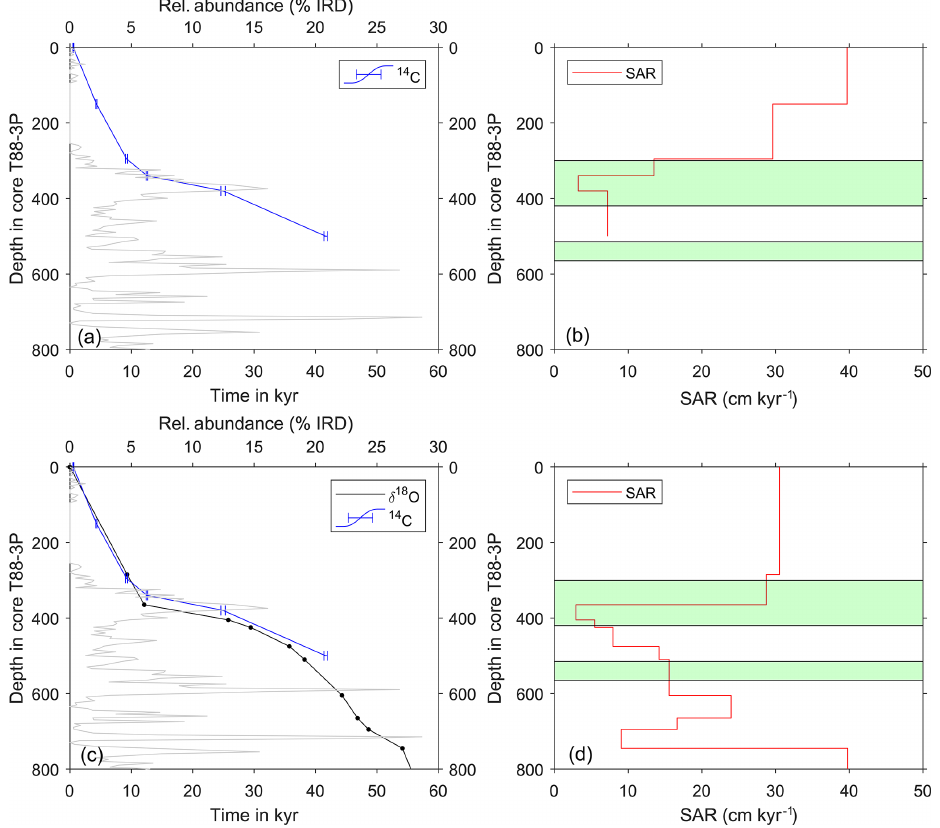
Figure 3. Age models of core T88-3P and their respective sediment accumulation rates (SARs). (a) Radiocarbon age model (see Table 1 and Table S1 in the Supplement for radiocarbon ages) and (b) the estimated SAR. (c) Oxygen isotope stratigraphy of pooled measurements of G. glutinata and G. bulloides (see Fig. 2) tuned to the North Greenland Ice Core Project (NGRIP) (see Table S2 in the Supplement for tie-point estimates). For comparison, the radiocarbon age model (blue line) is plotted alongside the tuned oxygen isotope age model (black line). IRD downcore is plotted (grey) alongside the age models. (d) The estimated SAR for the tuned oxygen isotope age model. Green panels in panels (b) and (d) highlight depths in core where single-foraminifera stable isotope analysis was performed. See Table 1 and Table S1 in the Supplement for radiocarbon measurements and Table S2 in the Supplement for δ 18 O tie points. Table 1. Raw and calibrated radiocarbon ages. Conventional radiocarbon age represents the measured radiocarbon age (see Table S1 in the Supplement) corrected for isotopic